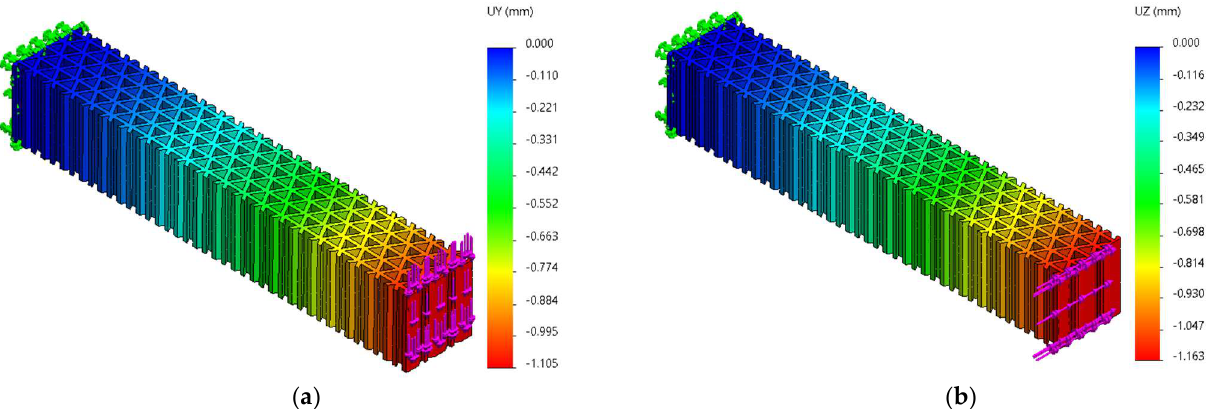
Figure 24. Cantilever beam. The displacement charts for the triangle structure: ( a ) α = 0 ° , ( b ) α = 90 ° .